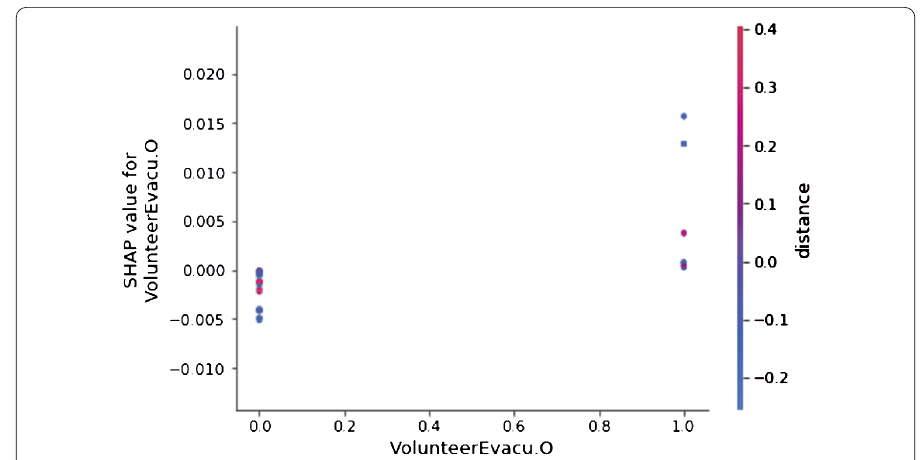
Figure 11 SHAP values of voluntary evacuation of origin with the interaction of distance